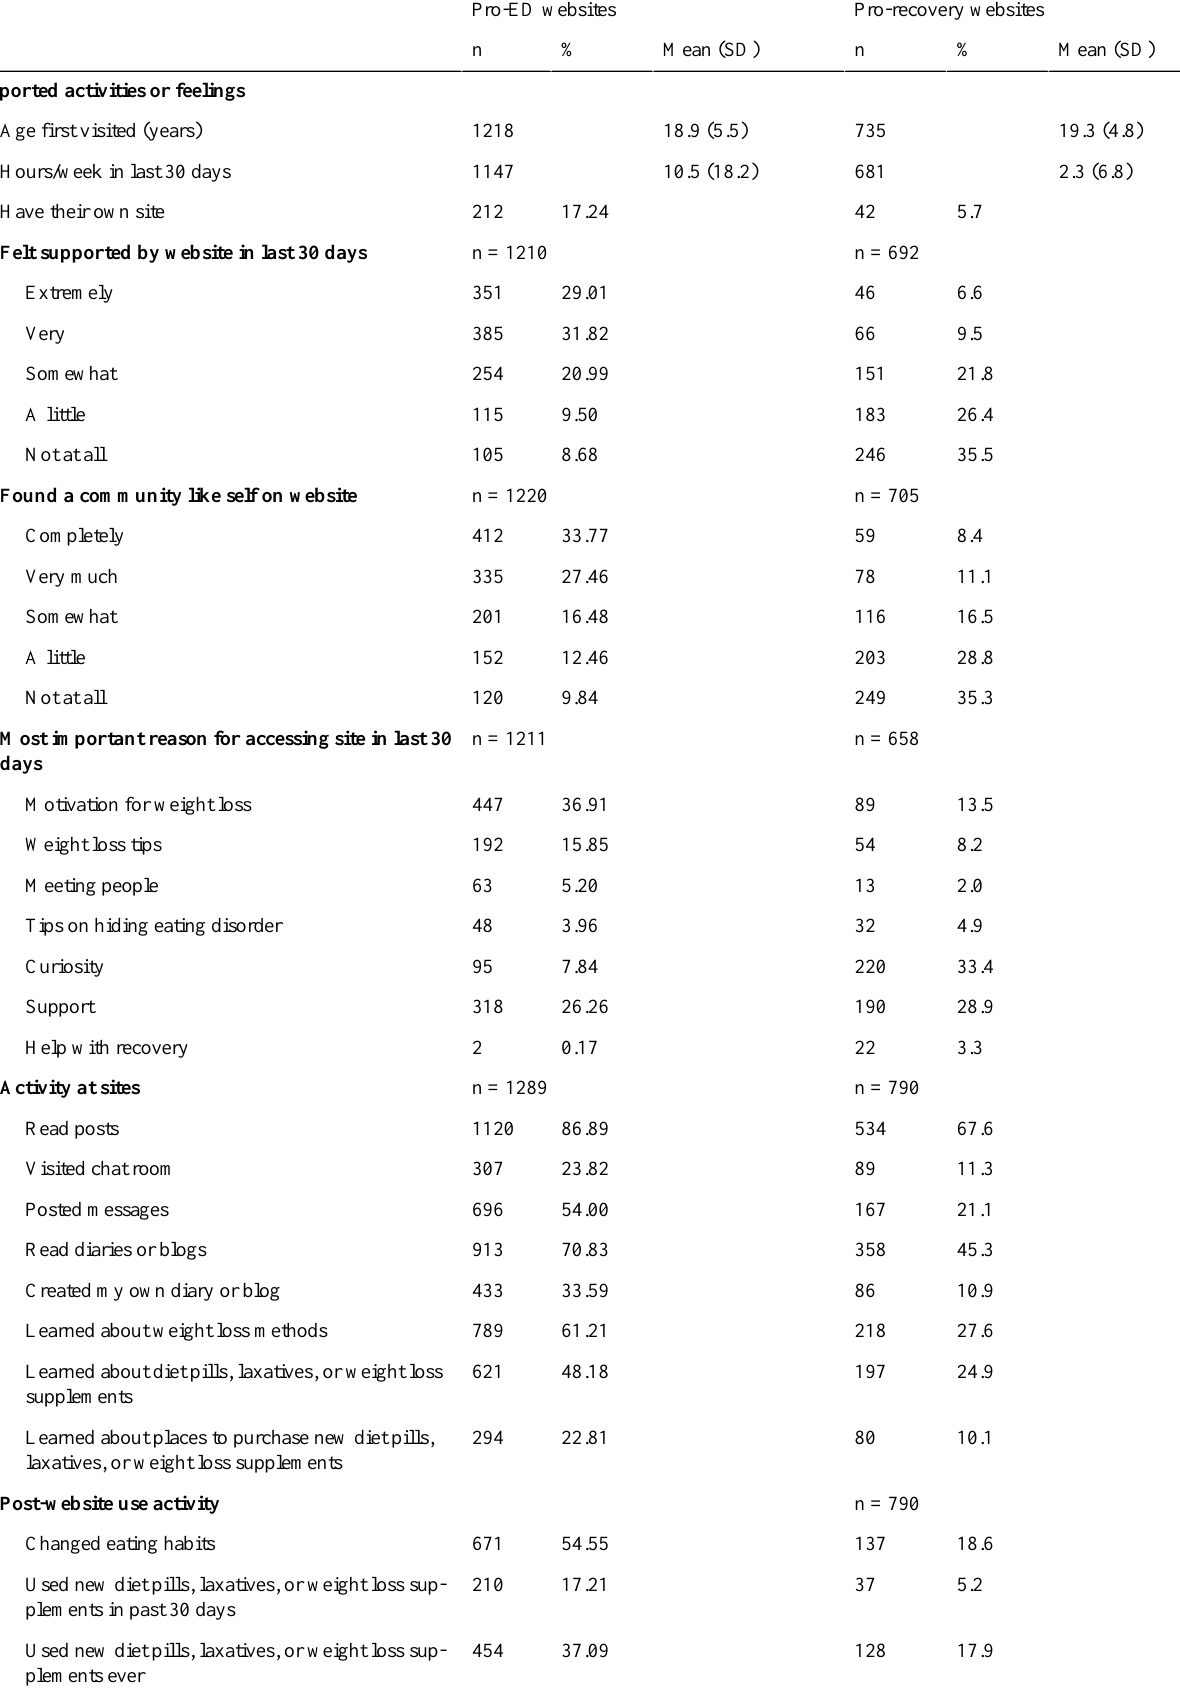
Table 2. Online activities and feelings of the study overall population on pro-eating disorder (pro-ED) websites and of the subgroup using pro-recovery